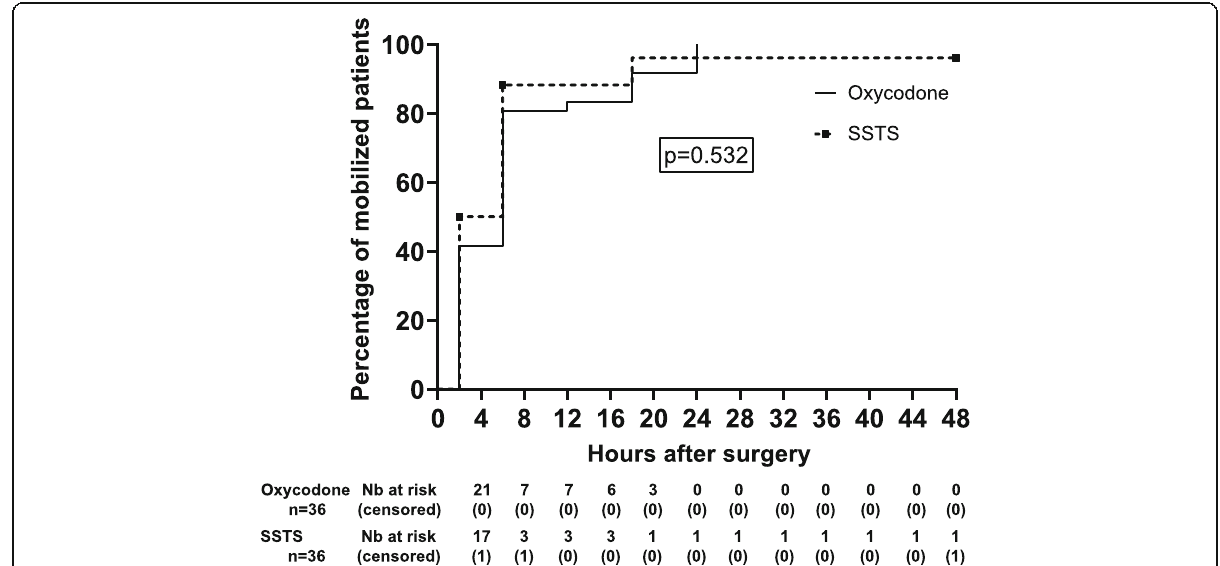
Fig. 4 Kaplan – Meier cumulative event rates for time to first mobilization. Solid square indicates censored patient. No statistical difference was found. SSTS = sufentanil sublingual tablet